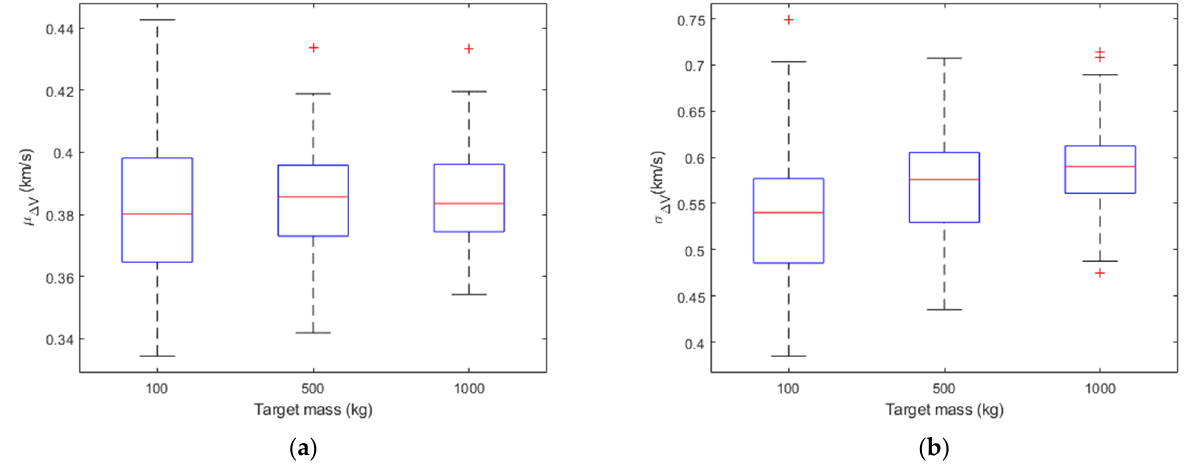
Figure 2. Mean ( a ) and standard deviation ( b ) of velocity distribution of sample fragments for different values of target mass for an impact velocity of 5 km/s. Mass of projectile is assumed to be 100 kg.